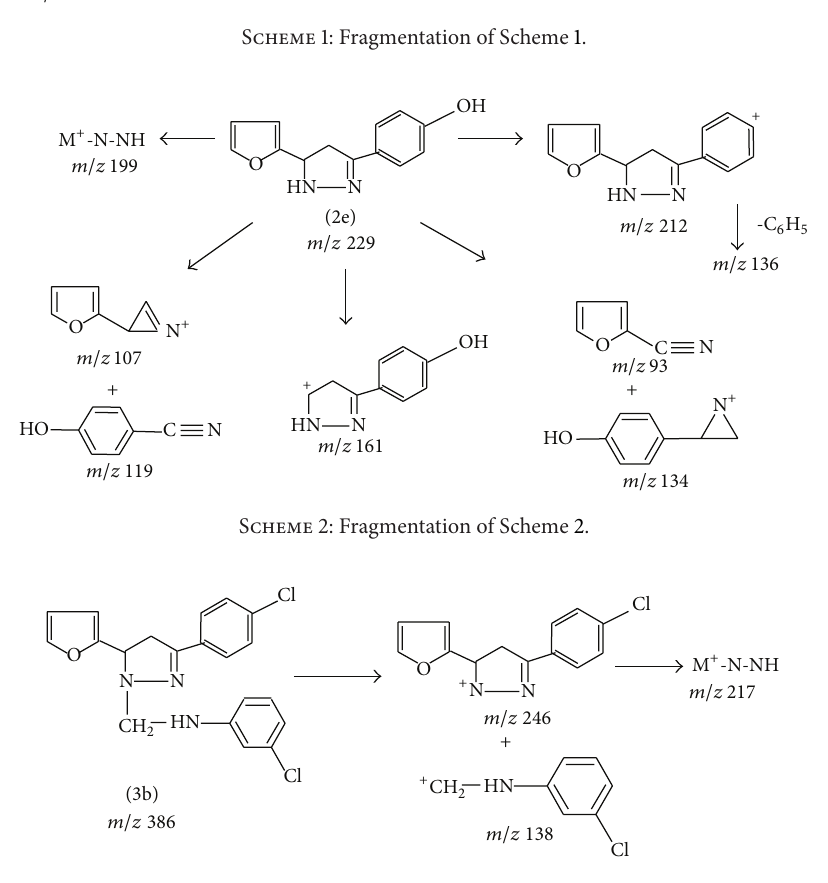
Scheme 3: Fragmentation of Scheme 3. Table 2: Molinspiration calculation for synthesized compounds